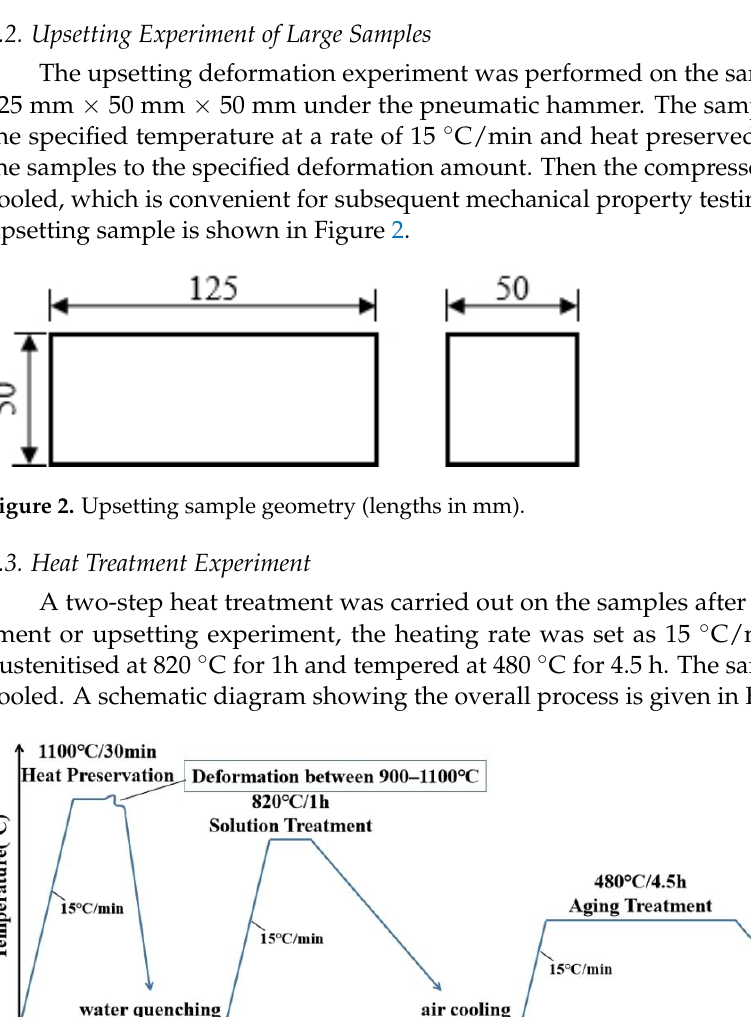
Figure 3. Schematic of the heat treatment.